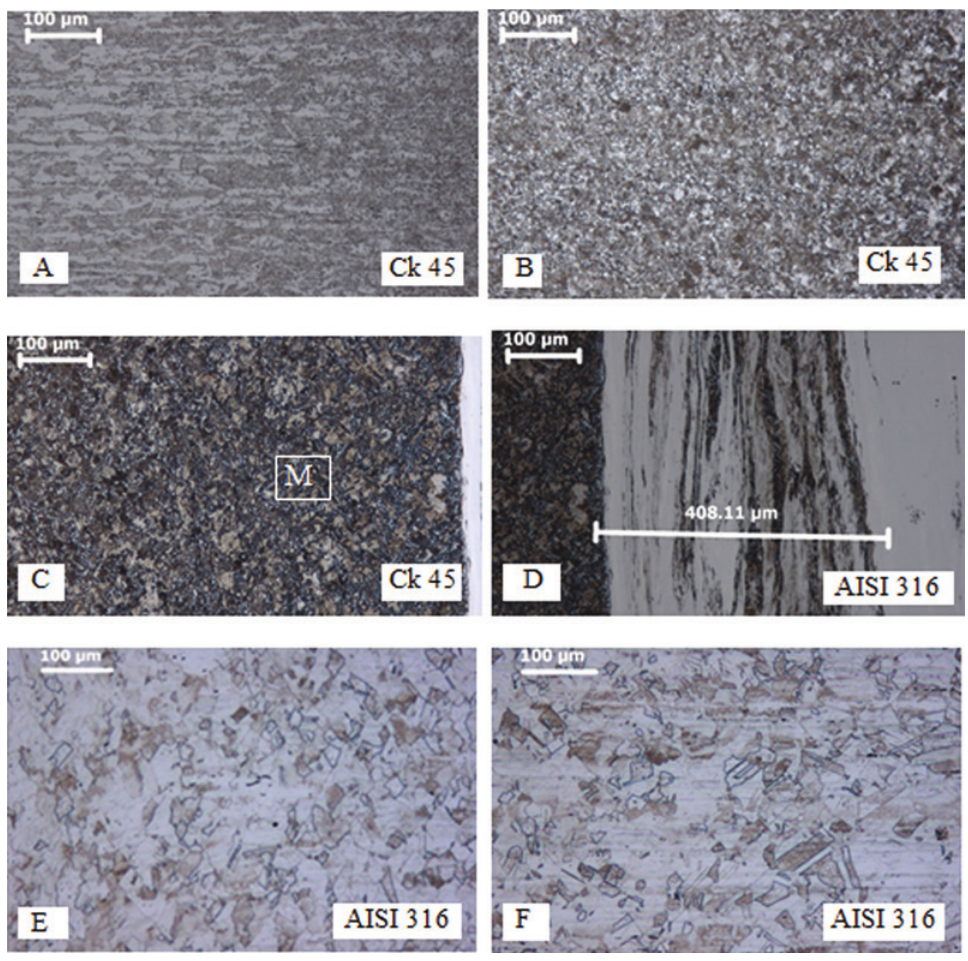
Fig. 6: Optical microstructures of welded sample in the different zones (M: